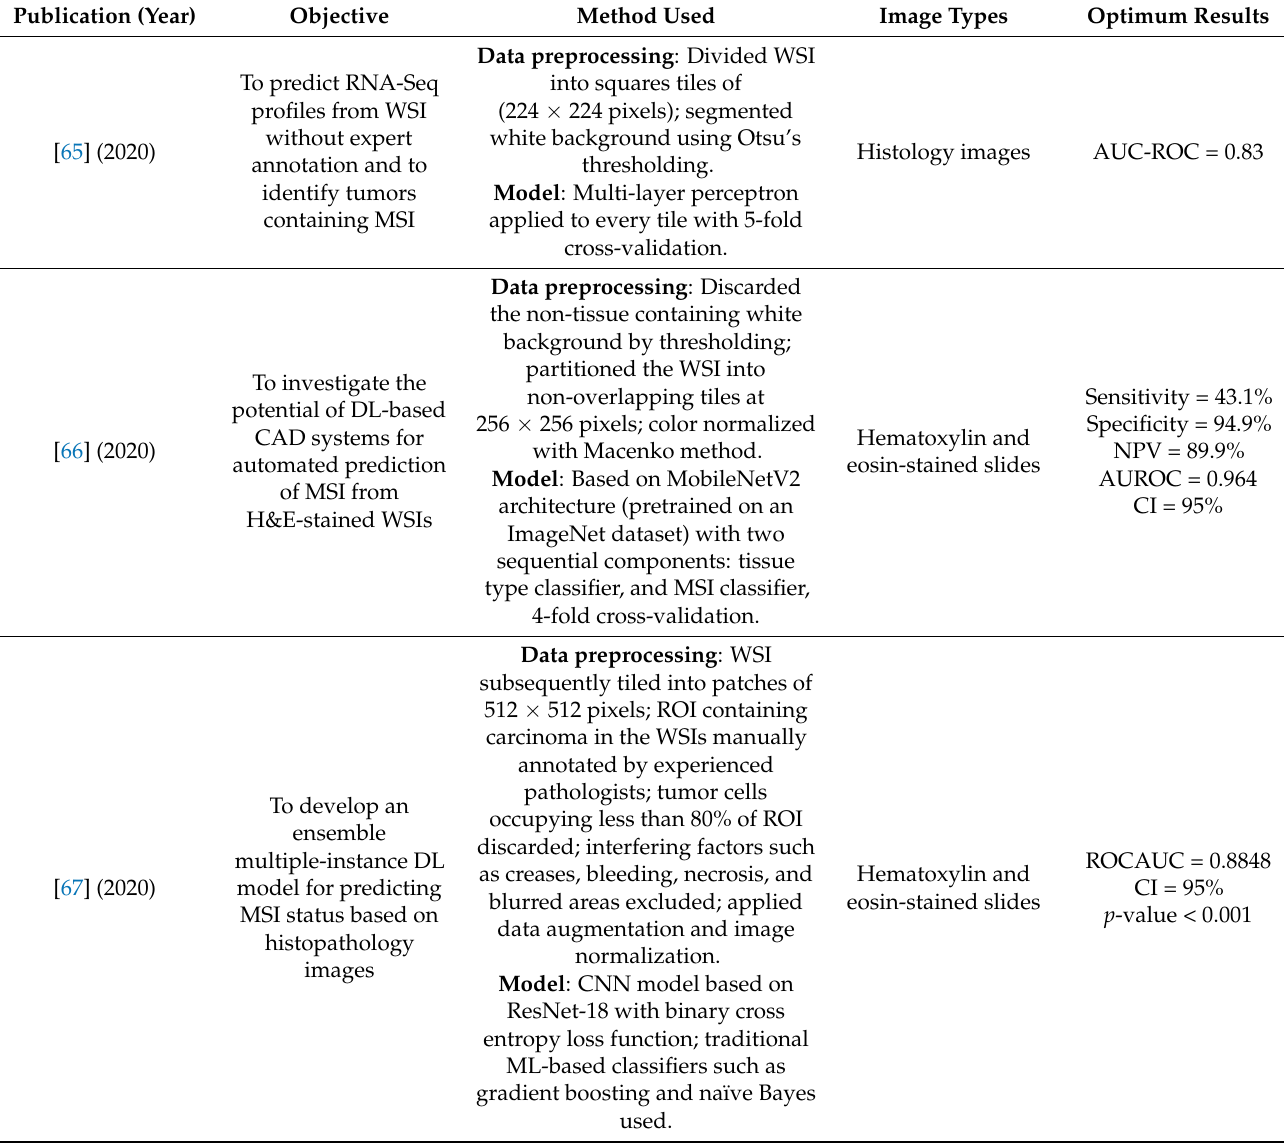
Table 4. Some recently published articles on MSI detection in CRC by using DL